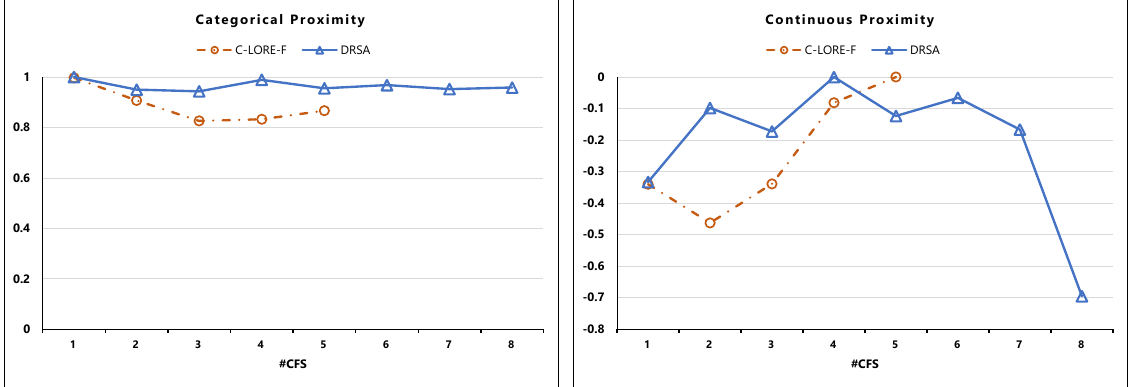
Figure 7. Proximity of counterfactual examples, in Categorical and Continuous attributes. The numbers in the y -axis represent the metrics values (the higher values, the better performance), while the x -axis represents the number of generated counterfactual instances.